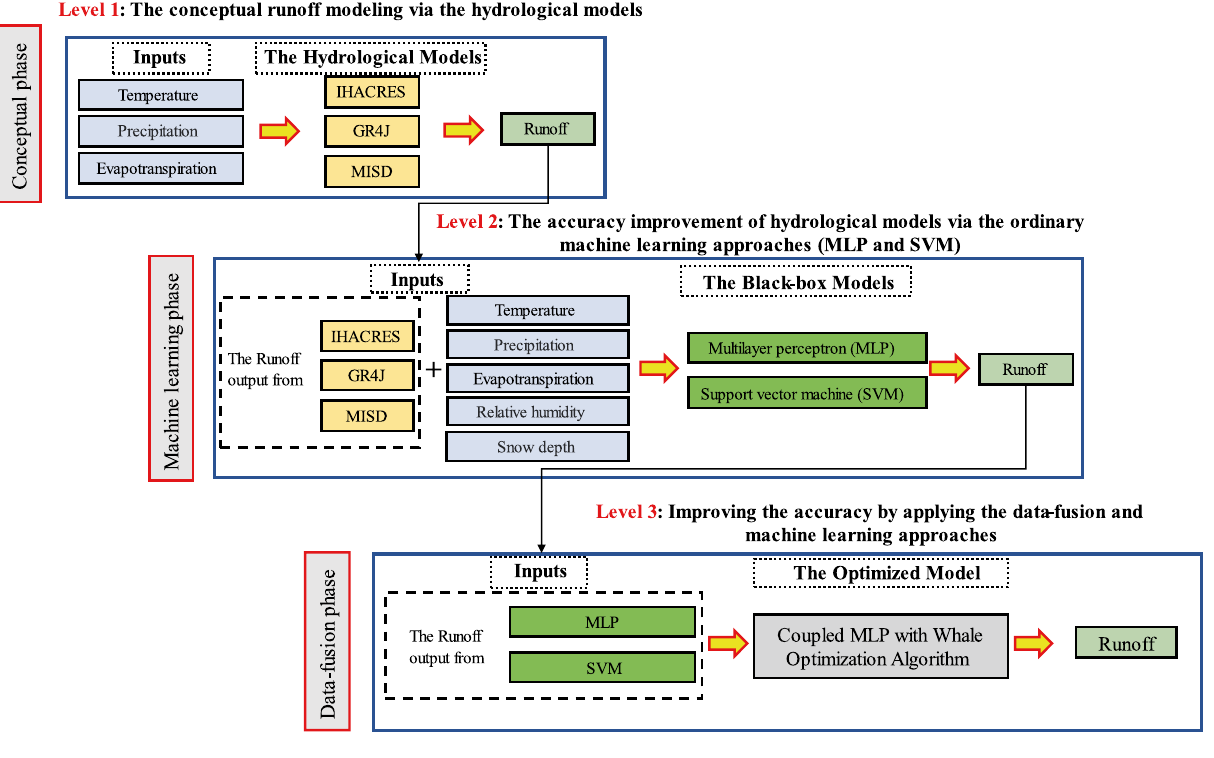
Figure 1. The flowchart of the applied